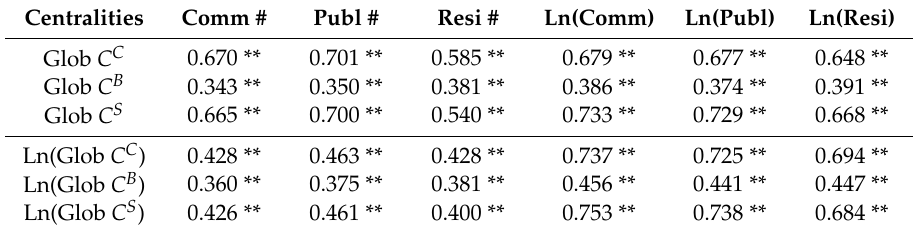
Table 1. Pearson’s r between global street centralities and land use intensities in a 1 km grid. Centralities Comm # Publ # Resi # Ln(Comm)